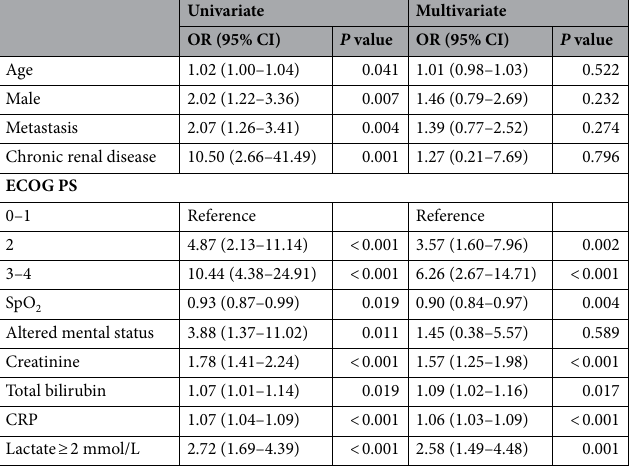
Table 3. Logistic regression analysis of the 30-day mortality in the development cohort. CI confidence interval, CRP C-reactive protein, ECOG Eastern Cooperative Oncology Group, OR odds ratio, PS performance status, SpO 2 peripheral oxygen saturation.